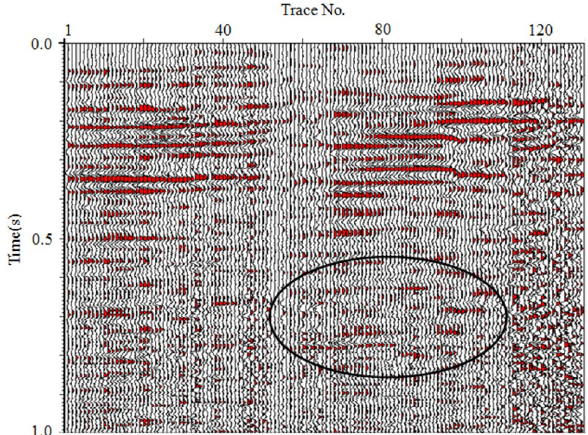
Fig. 11 Filtered section by means of a band-pass filter with a param- eter of (0, 10, 70, 80) Hz. Background noise remains strong, and events are distorted